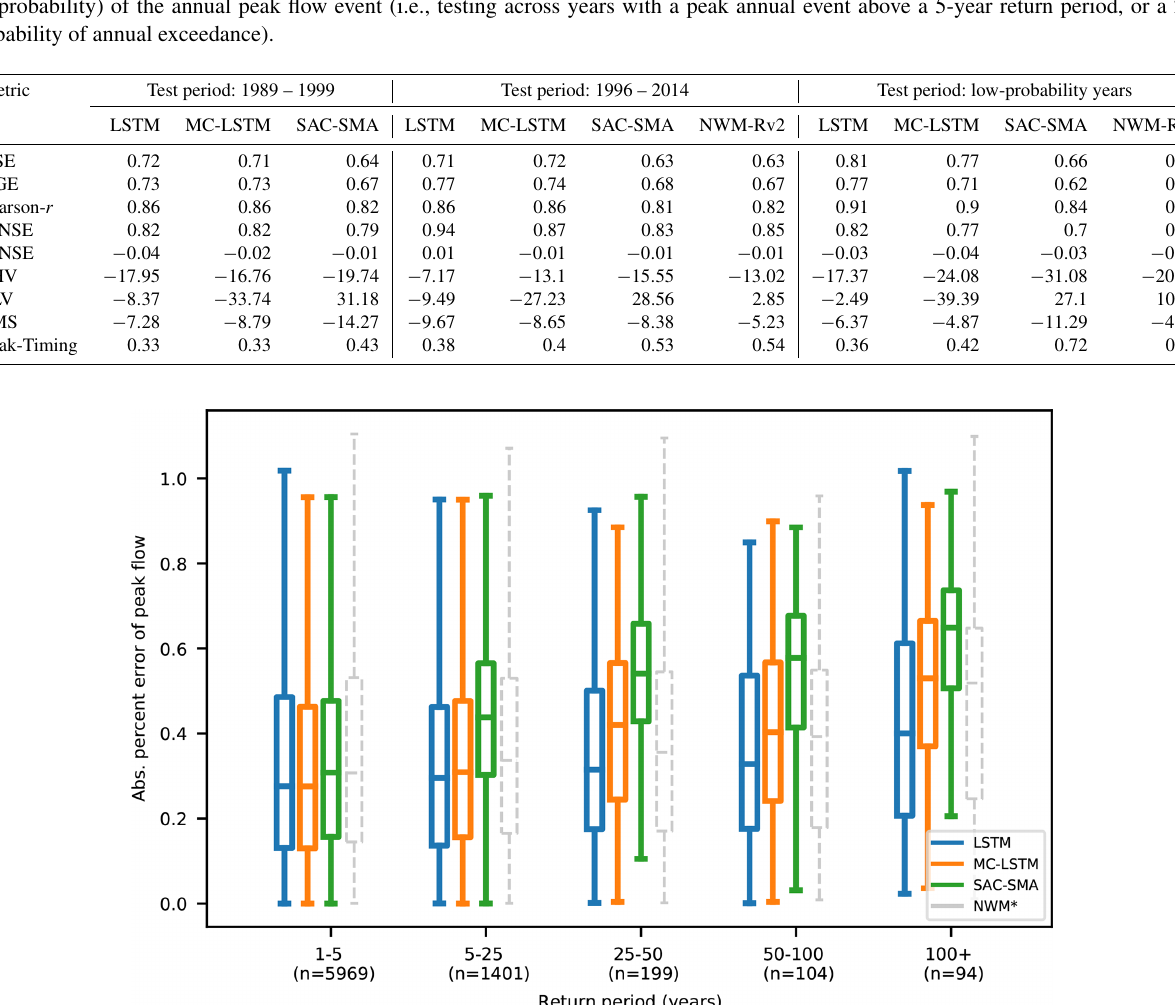
Figure 1. Average absolute percent bias of daily peak flow estimates from four models binned down by return period, showing results from models trained on a contiguous time period that contains a mix of different peak annual return periods. All statistics shown are calculated on test period data. The LSTM, MC-LSTM, and SAC-SMA models were all trained (calibrated) on the same data and time period. The NWM was calibrated on the same forcing data but on a different time